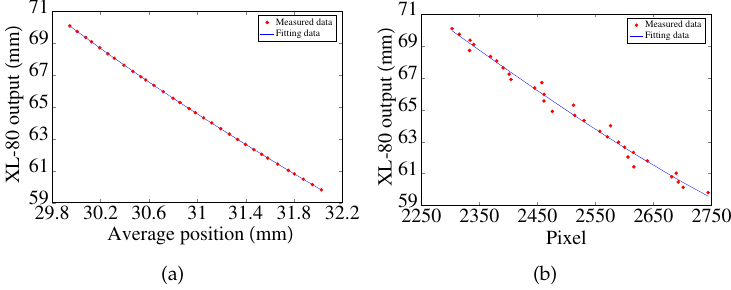
Figure 8. ( a ) Calibration results with laser beam pointing control; ( b ) Calibration results without laser beam pointing control.